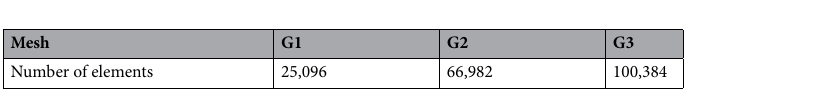
Table 2. Numerical test results for grid independency